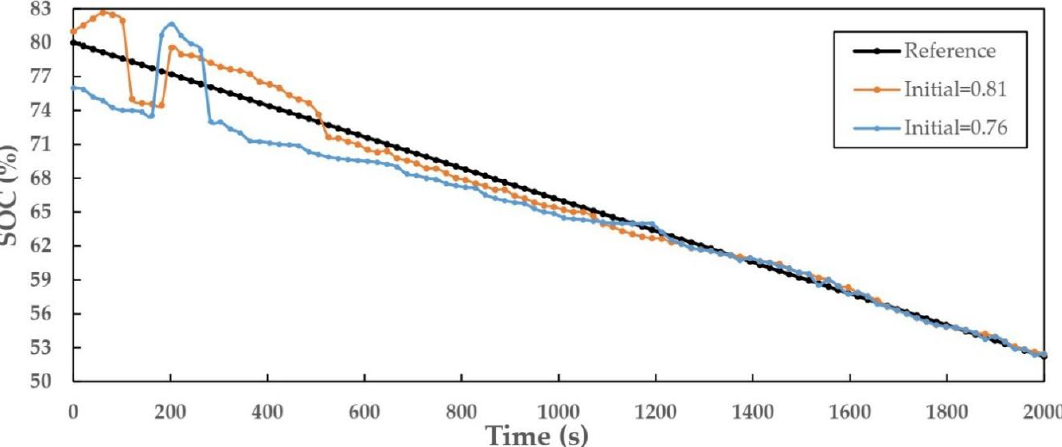
ff erent. Appl. Sci. 2019 , 9 , x FOR PEER REVIEW